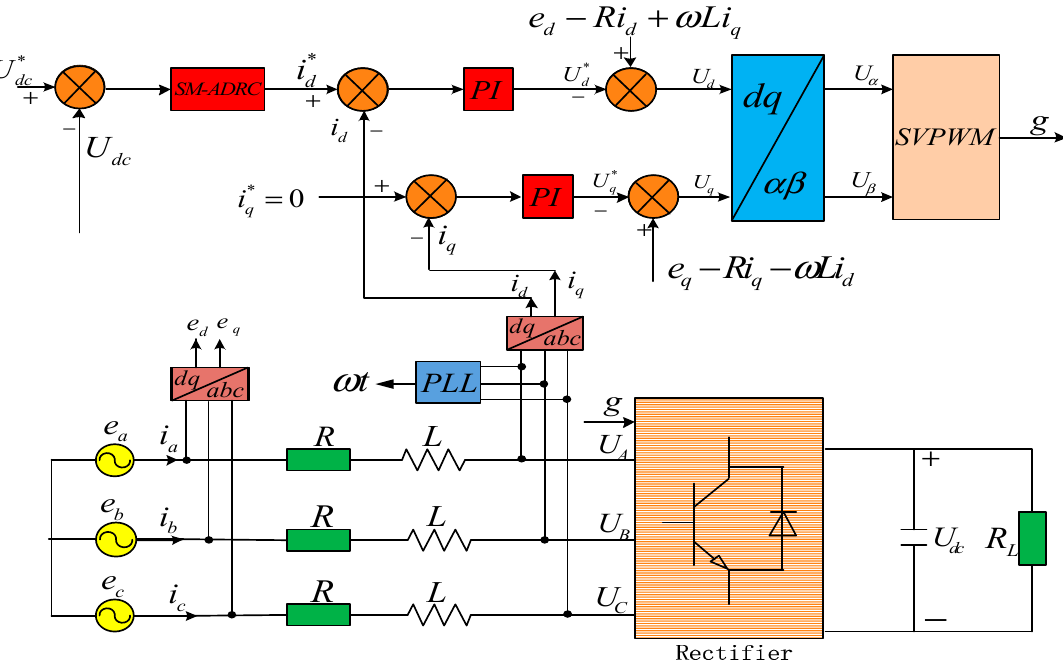
Figure 6. Application of SMADRC controller in DC distribution network bus voltage control.